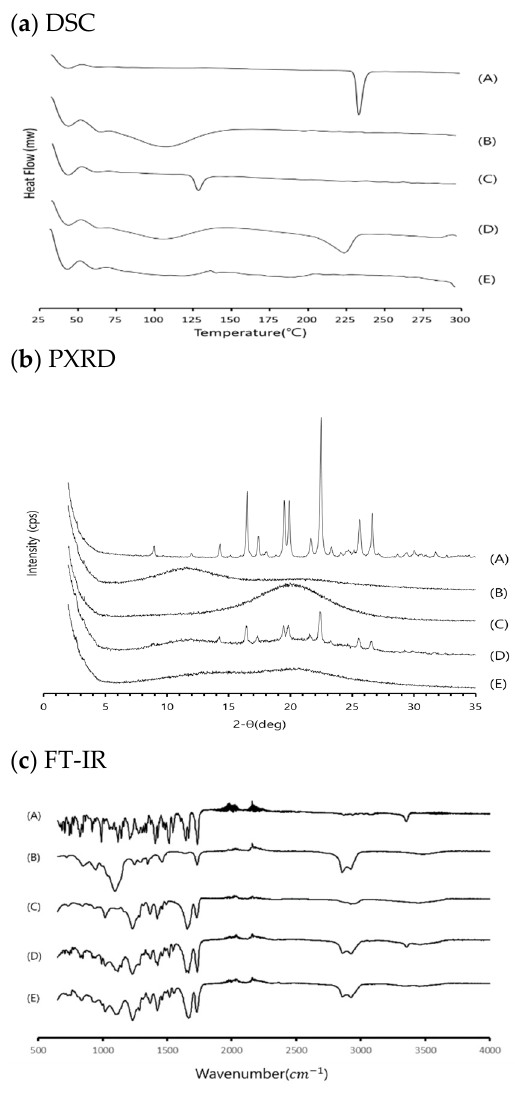
Figure 6. DSC ( a ), PXRD ( b ), and FT-IR ( c ) profiles of samples: (A) RXB, (B) PVP VA64, (C) Cremophor ® RH 40, (D) physical mixture, and (E) optimized RXB-ASD. The FT-IR spectra of samples (RXB, PVP VA 64, Cremophor ® RH 40, and RXB-ASD)